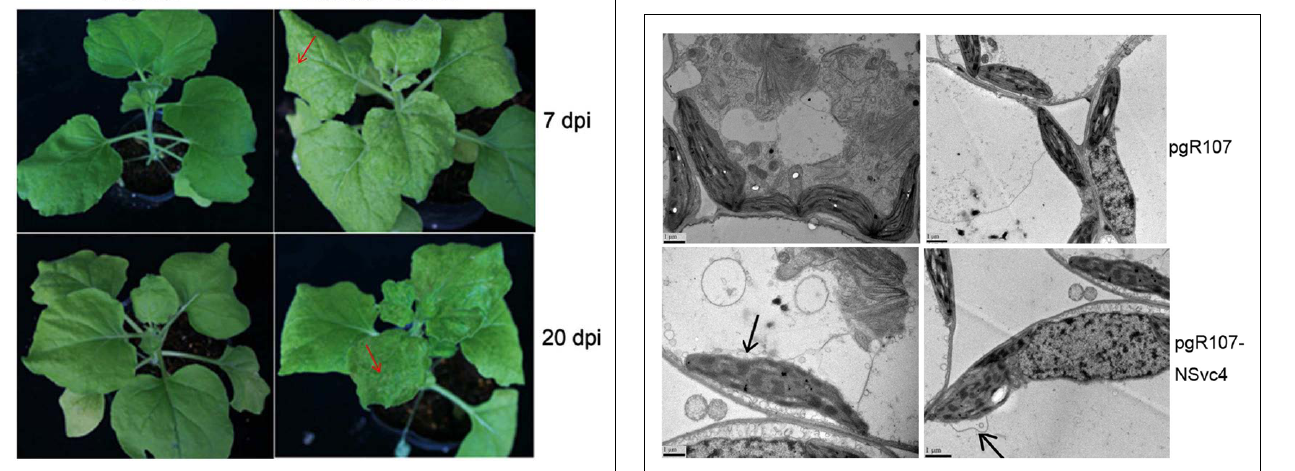
FIGURE 9 | Ultrastructural changes resulting from infection with wild type PVX or PVX-NSvc4. Tissue sections were prepared from the leaves infected with the wild type PVX or PVX expressing NSvc4. Morphological changes in chloroplast were only observed in plants infected with PVX expressing NSvc4. Arrows indicate alterations of chloroplast membrane.